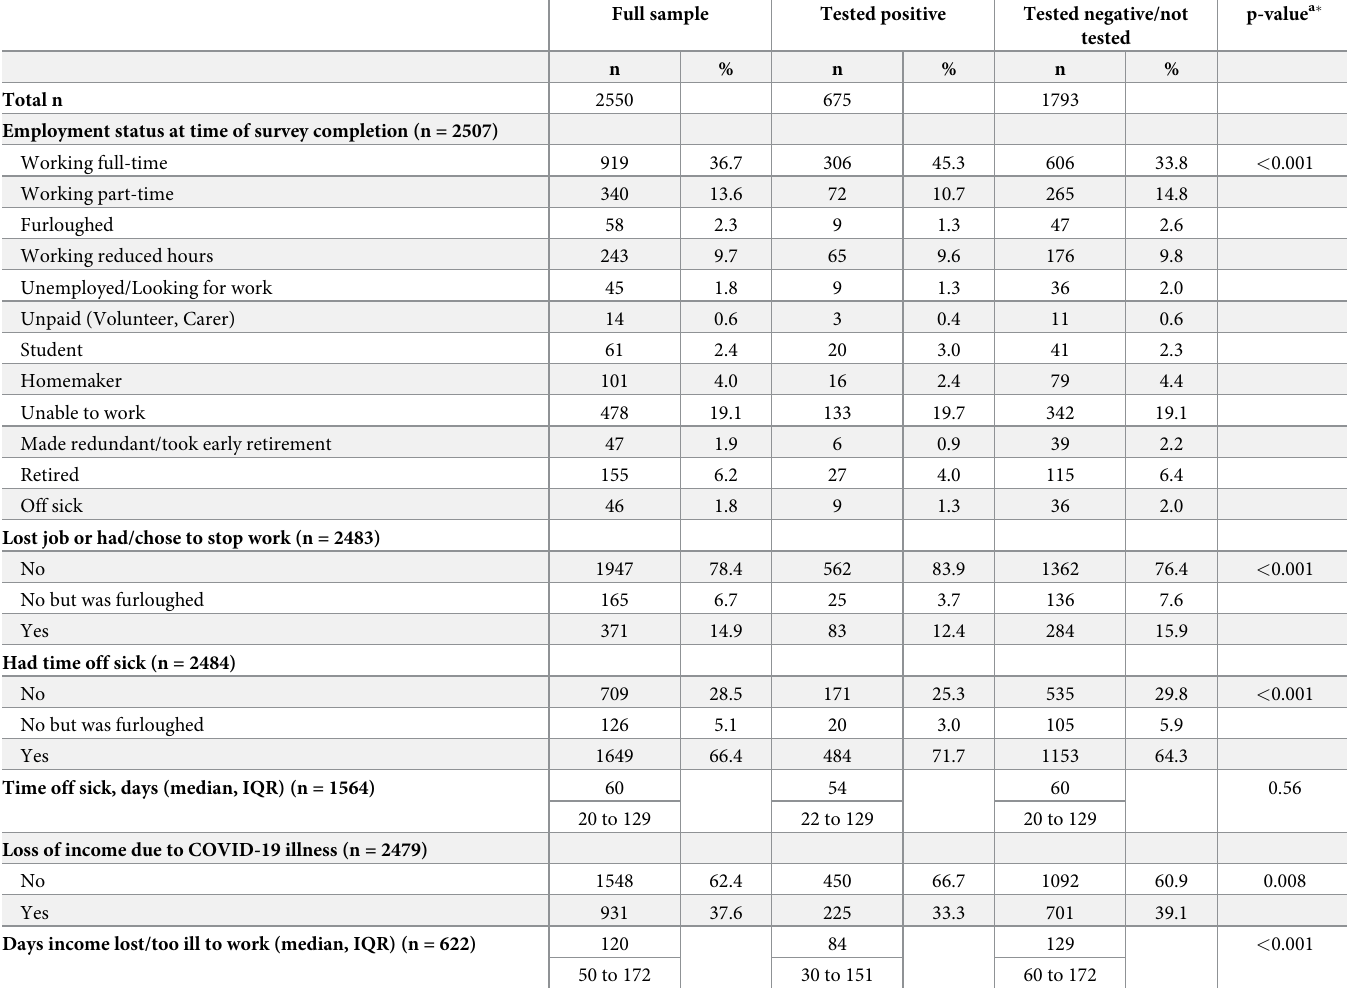
Table 6. Employment status and impact of illness on